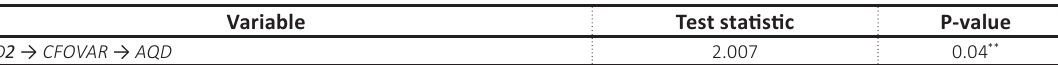
Source: Data processed with